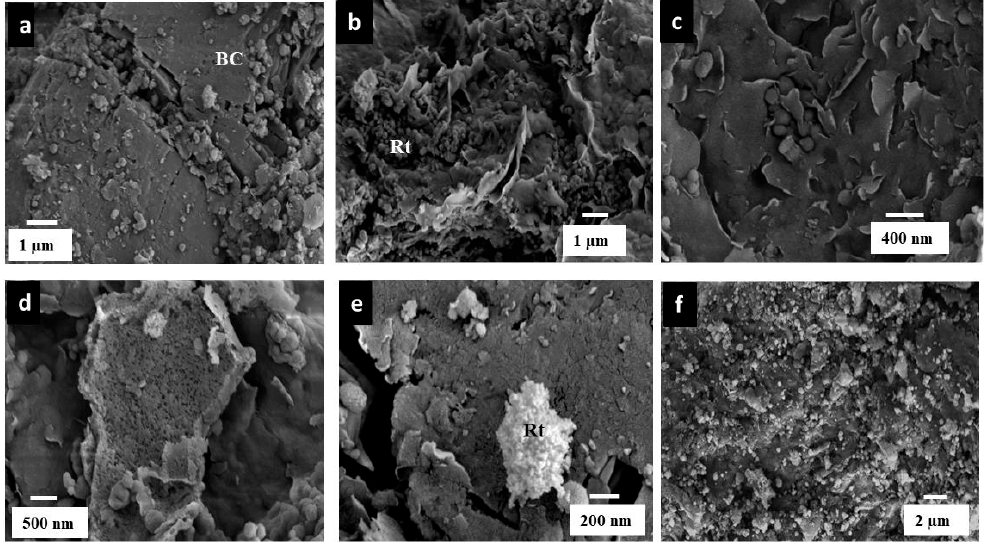
Figure 3. FESEM images of the Rt/BC material at different magnification scales. ( a ) exfoliated BC; ( b , c ) Rt/BC composite;( d – f ) the aggregated Rt nanoparticles decorated BC sample.